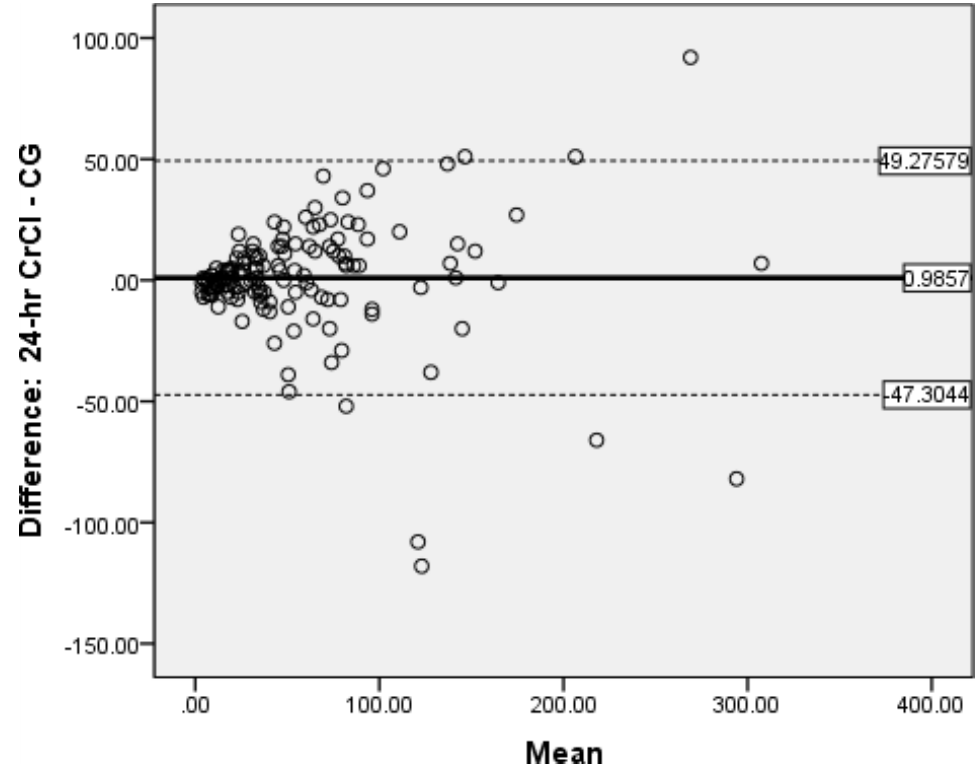
Medicines 2021 , 8 , x FOR PEER REVIEW Figure 2. Bland-Altman plot of CG vs. 24-h CrCl. Figure 2. Bland-Altman plot of CG vs. 24-h CrCl.